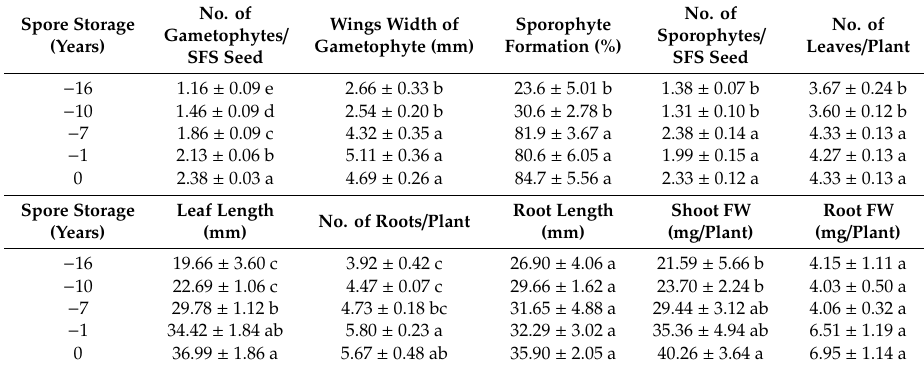
Table 3. Sporophyte formation and growth of SFS (synthetic seeds using fern spores) produced with bracken spores stored for di ff erent periods at 4 ◦ C.